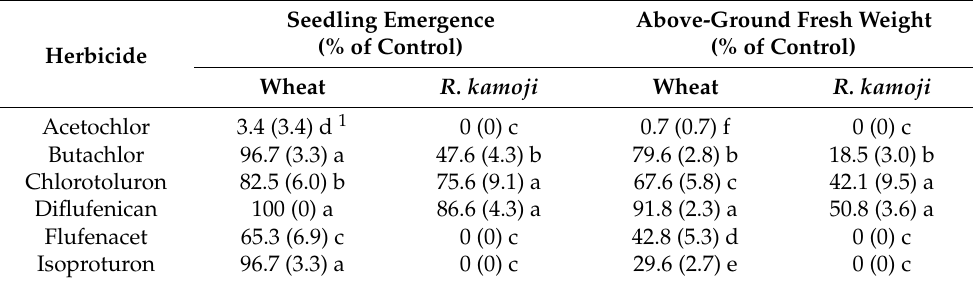
Table 2. Effect of different PRE herbicides on seedling emergence inhibition (%) and above-ground fresh weight reduction (%) in wheat and R. kamoji 21 days after treatment. Seedling Emergence Above-Ground Fresh Weight (% of Control) (% of Control) Herbicide Wheat Wheat